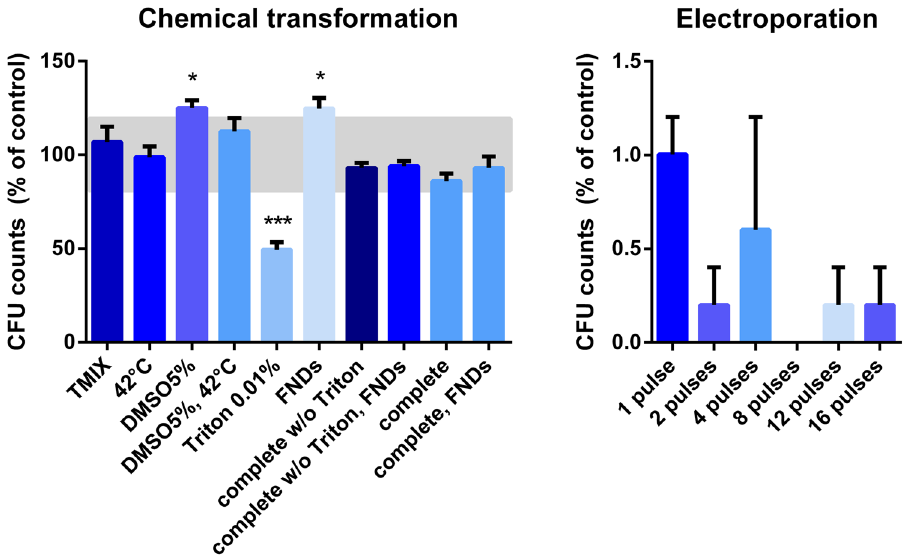
Figure 3. Survival of yeast cells after performing the interventions and different steps in the transformation protocols separately. Colony forming units (CFUs) are a measure for the survival of viable cells after either the chemical transformation or the electroporation protocol. ( A ) The greatest reduction of viability occurs after the addition of 0.01% Triton. The addition of FNDs to the treatment does not decrease the viability. Bars represent averages of triplicates out of two independent experiments. An area of + / − 20% around 100% is deemed as ‘normal viability,’ ( B ). Electroporation reduces viability by a factor 10 2 . In all samples FNDs were also added. In the case of 8 pulses, cell viability was completely reduced. For the electroporation protocol all decreases were significant (p < 0.0001). Bars represent averages of replicates out of two independent experiments, error bars show the Standard Error of the Mean. Significance is tested compared to the control situation. * p <